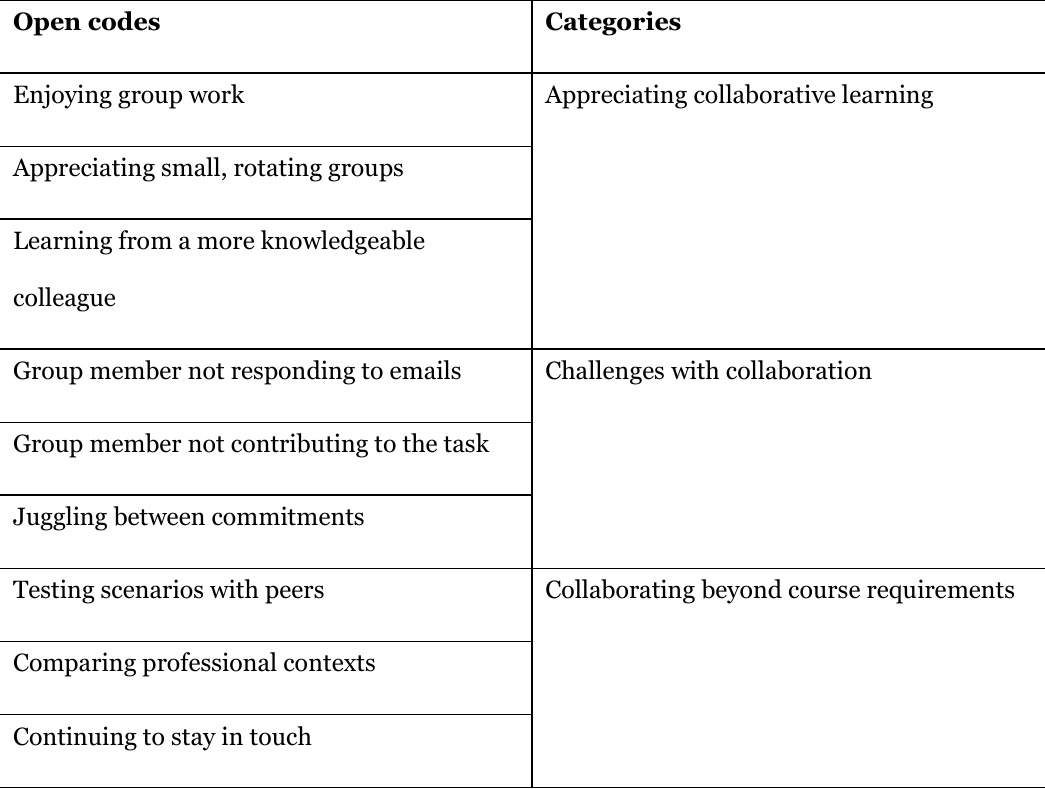
Example of Codes and Categories Open